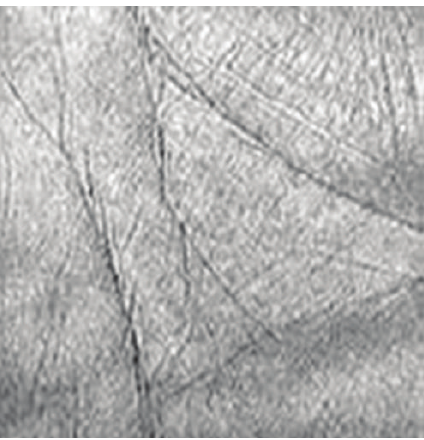
Figure 5: Effect of quantum adaptive median filtering algorithm.